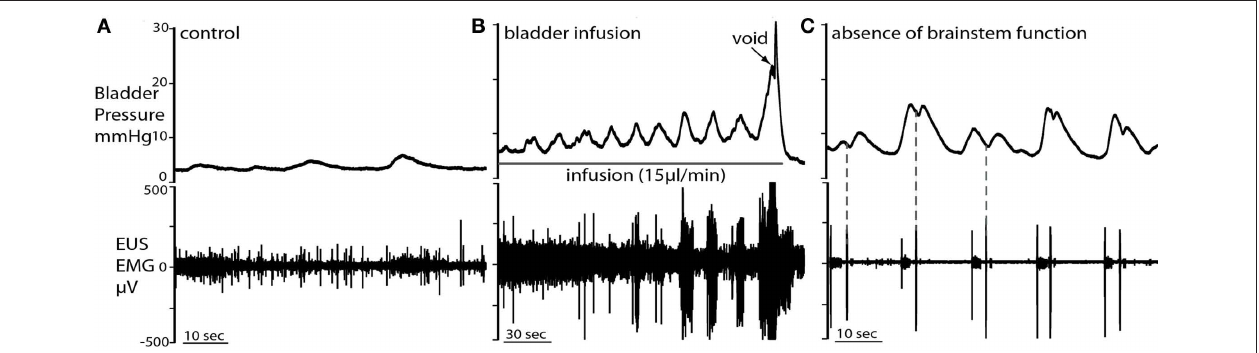
indicated by a loss of phrenic activity and voiding), the NMCs became biphasic and their amplitude significantly increased. In the first contractile phase of each NMC, tonic EUS firing was observed. The subsequent single burst of the EUS was followed by a second pressure oscillation (dotted line) and they could now be associated with leakage of